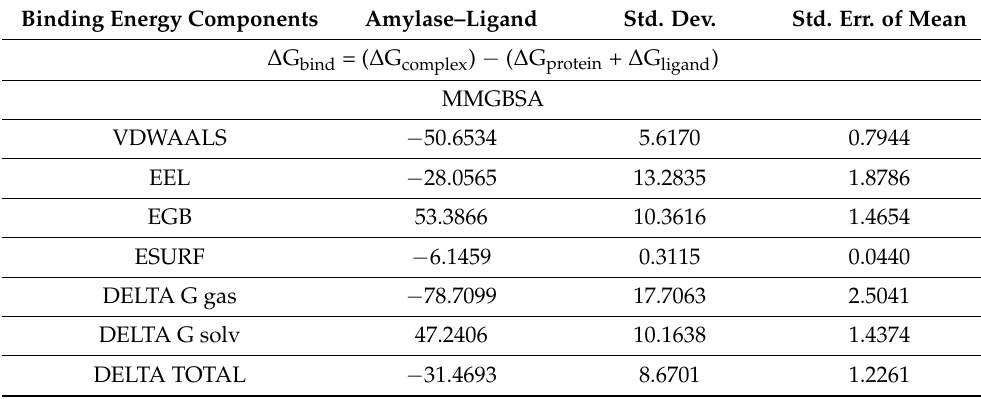
Table 2. MM/GBSA calculated values for different parameters of protein–ligand